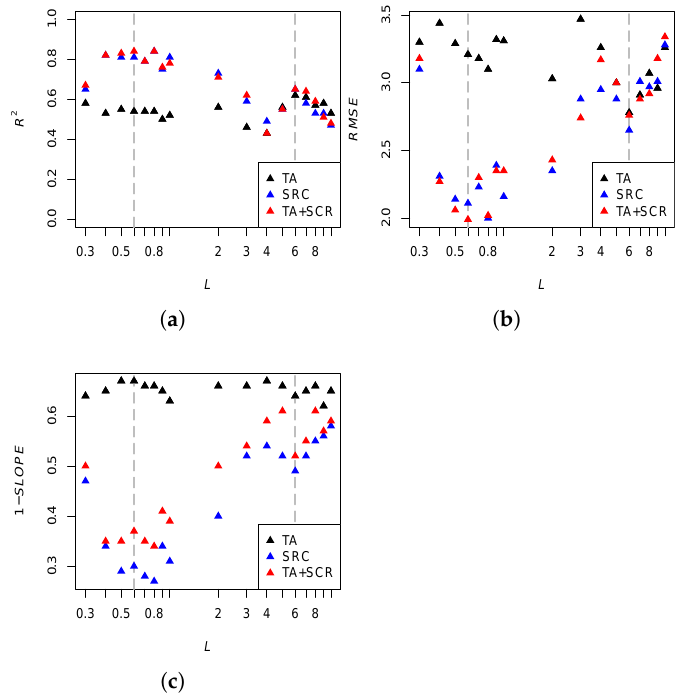
Figure 7. Relations between logarithmized scale level L and accuarcy metrics R 2 and SLOPE VAL ( c ) (cf., Table3) for the parametrization variants terrain attributes (TA), SCMaP-SRC (SRC), and terrain attributes + SCMaP-SRC (TA + SRC). The gray dashed line refers to scale levels L = 0.6 and L = 6 (cf., Figures 8 and